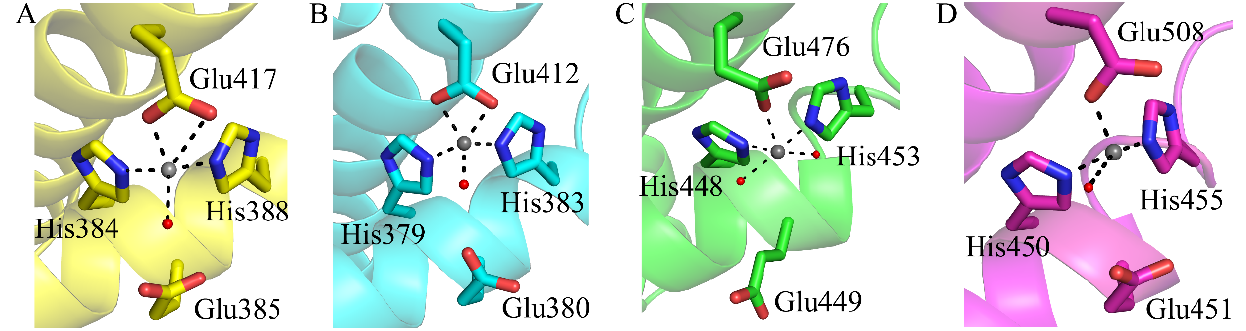
Figure 7. Close-up views of the zinc binding site. ( A ) Co DPP III. ( B ) Ca DPP III (PDB ID: 6EOM). ( C ) Bt DPP III (PDB ID: 5NA7). ( D ) h DPP III (PDB ID: 3FVY). The catalytic zinc ion and water are represented by a gray and red sphere, respectively.